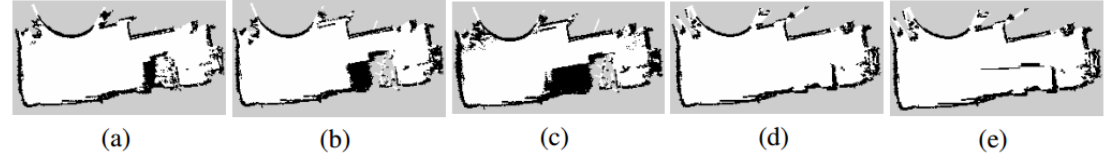
Figure 11. Real-word environment. ( a ) a snapshot of the real environmen; ( b ) the 3D representation of the environment with OctoMap, only occupied voxels are shown for visualization.